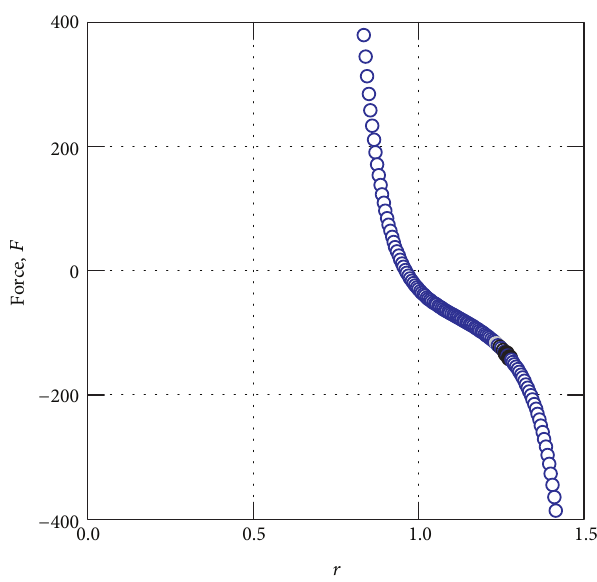
Figure 6: Total forces between two